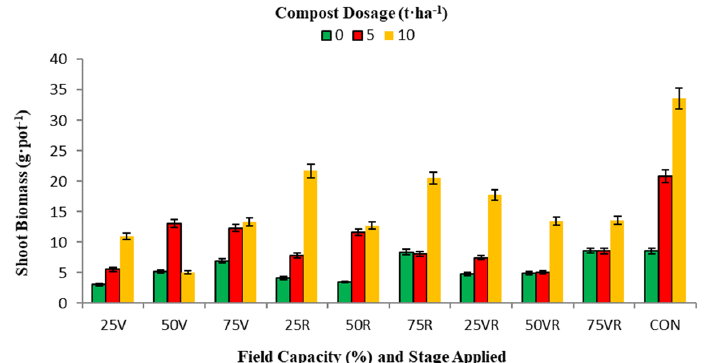
Figure 11. Effect of interaction of water regime, treatment stage and compost dosage on shoot biomass of okra The 25, 50 and 75% represent field capacity; V (vegetative), R (reproductive), and VR (vegetative and reproductive) represent the stage at which the deficit was applied. Data in the interaction analysed with Least Squares Means, and means separated with